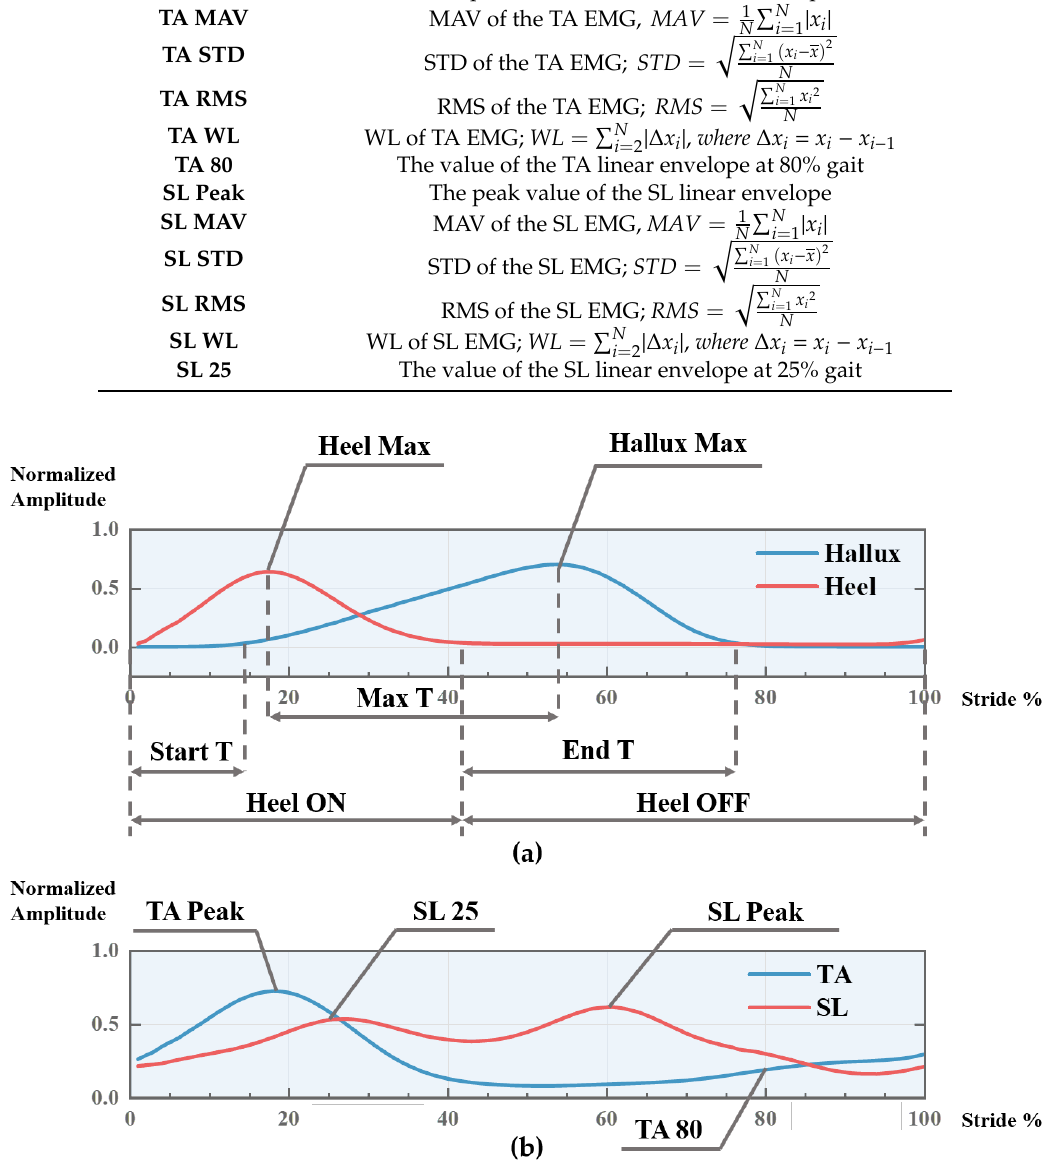
Figure 4. A sketch for depicting part of the extracted EMG and GRF features. ( a ) Sketch for GRF-based features; ( b ) sketch for EMG-based